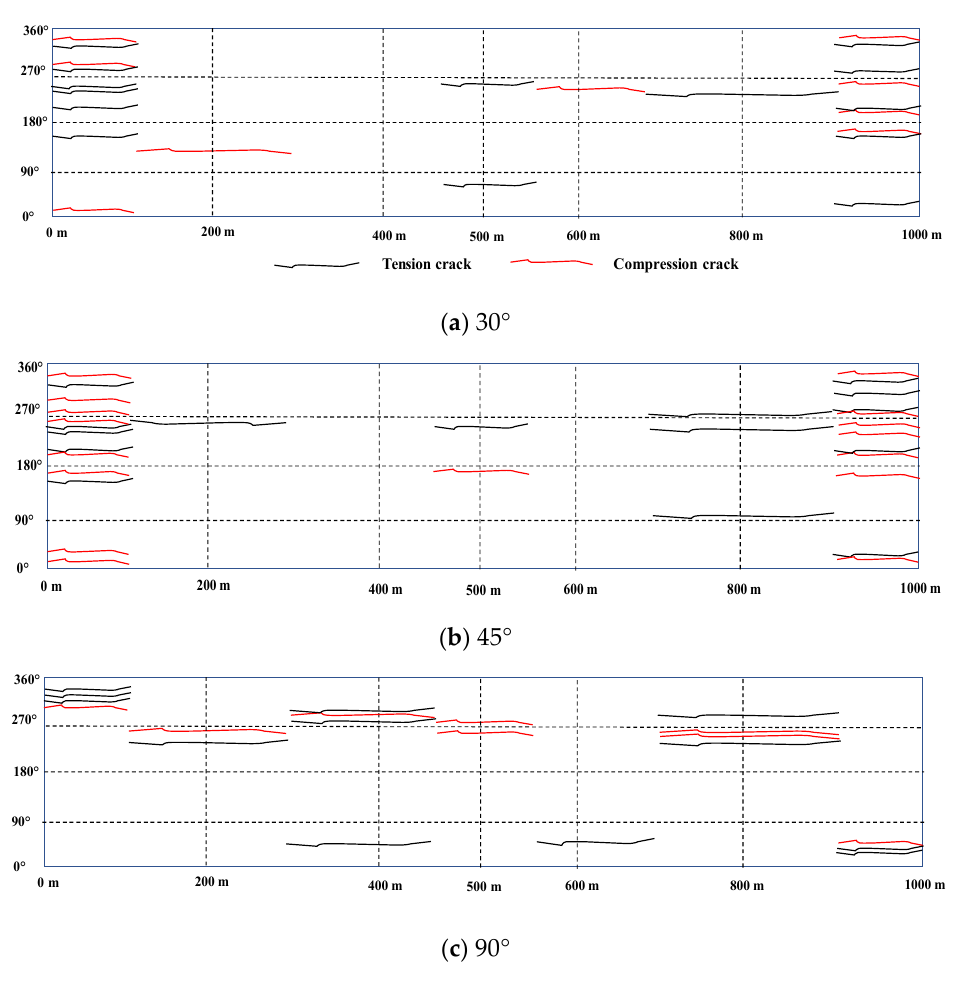
Figure 17. Schematic diagram of longitudinal cracks along the axial lining of the tunnel crossing different inclinations of adverse geological structure zones.